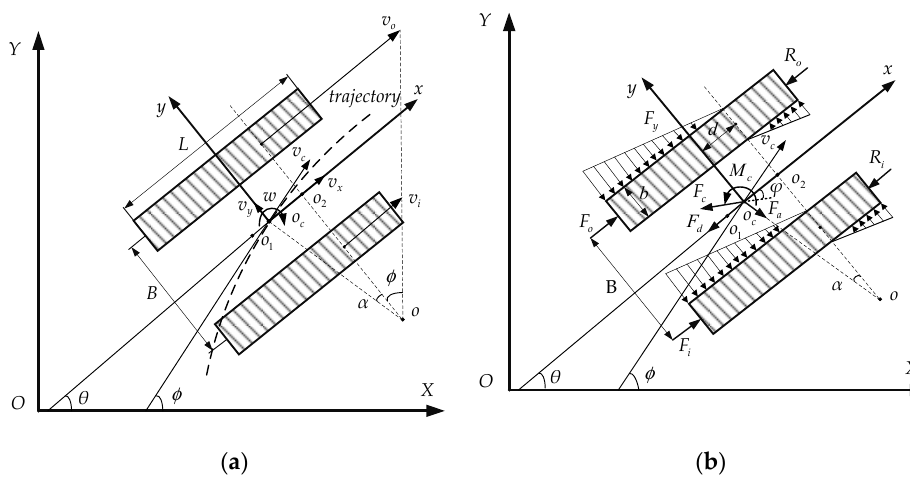
Figure 4. Motion analysis of the DSLV. ( a ) Kinematic analysis; ( b ) Dynamics analysis. The kinematic analysis of the vehicle motion process as displayed in Figure 4a. The vehicle motion on the O - XY of the geographic coordinate system can be considered as the synthesis of the forward motion with the centroid velocity v and the steering motion c v represent the decomposition variables with the angular velocity w , where v and y x of v on x axis and y axis, respectively, and the vehicle direction angle and the position c relative to O - X axis of the geographic coordinate system are represented by φ and θ , re-